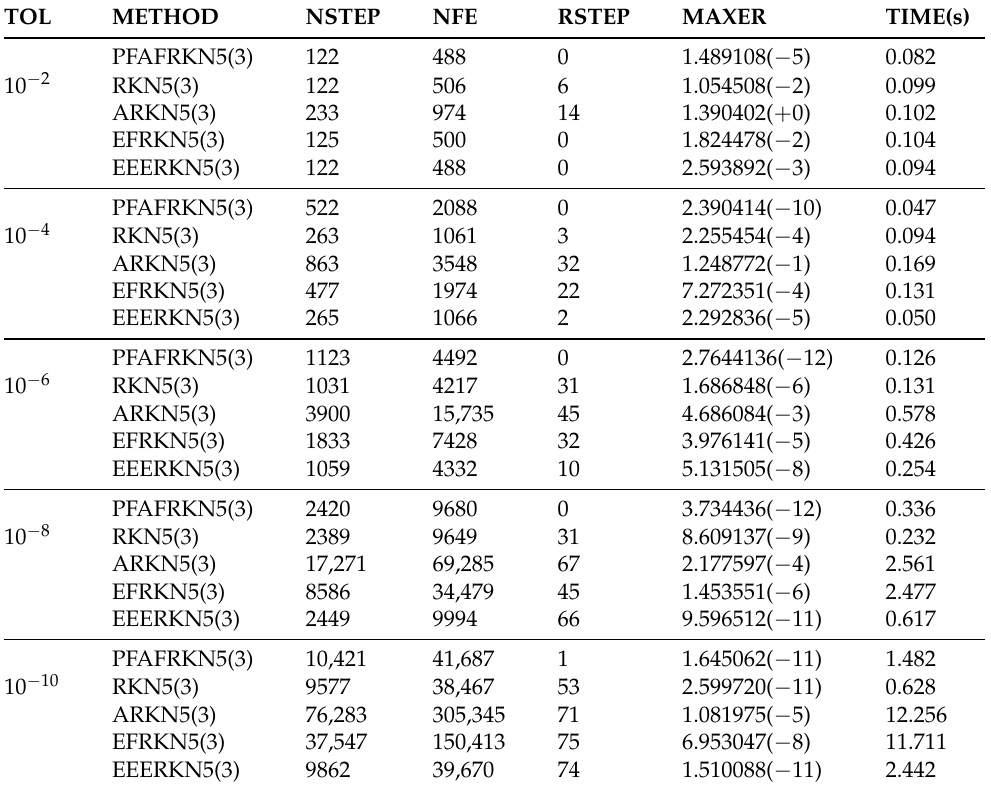
Table 6. Numerical data corresponding to Problem 5.